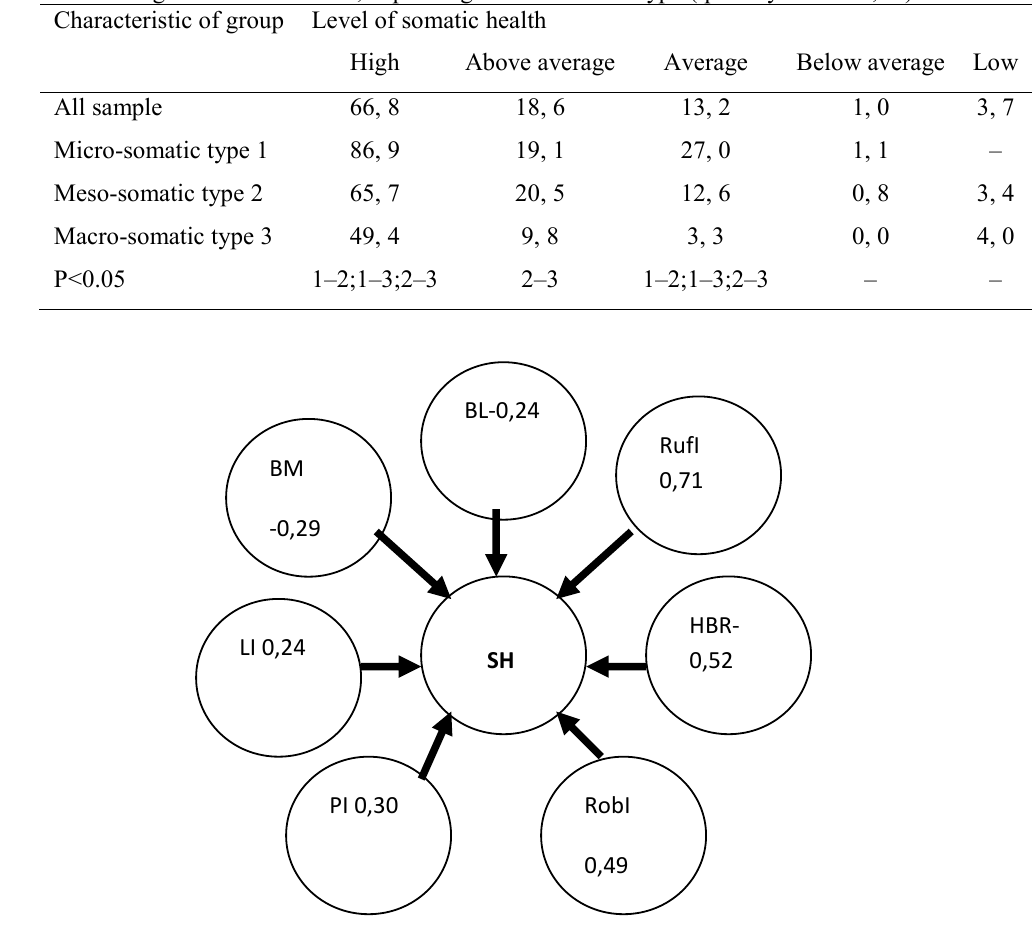
Table 2. The level of girls’ somatic health, depending on heir somatic type (quantity of tested, %)